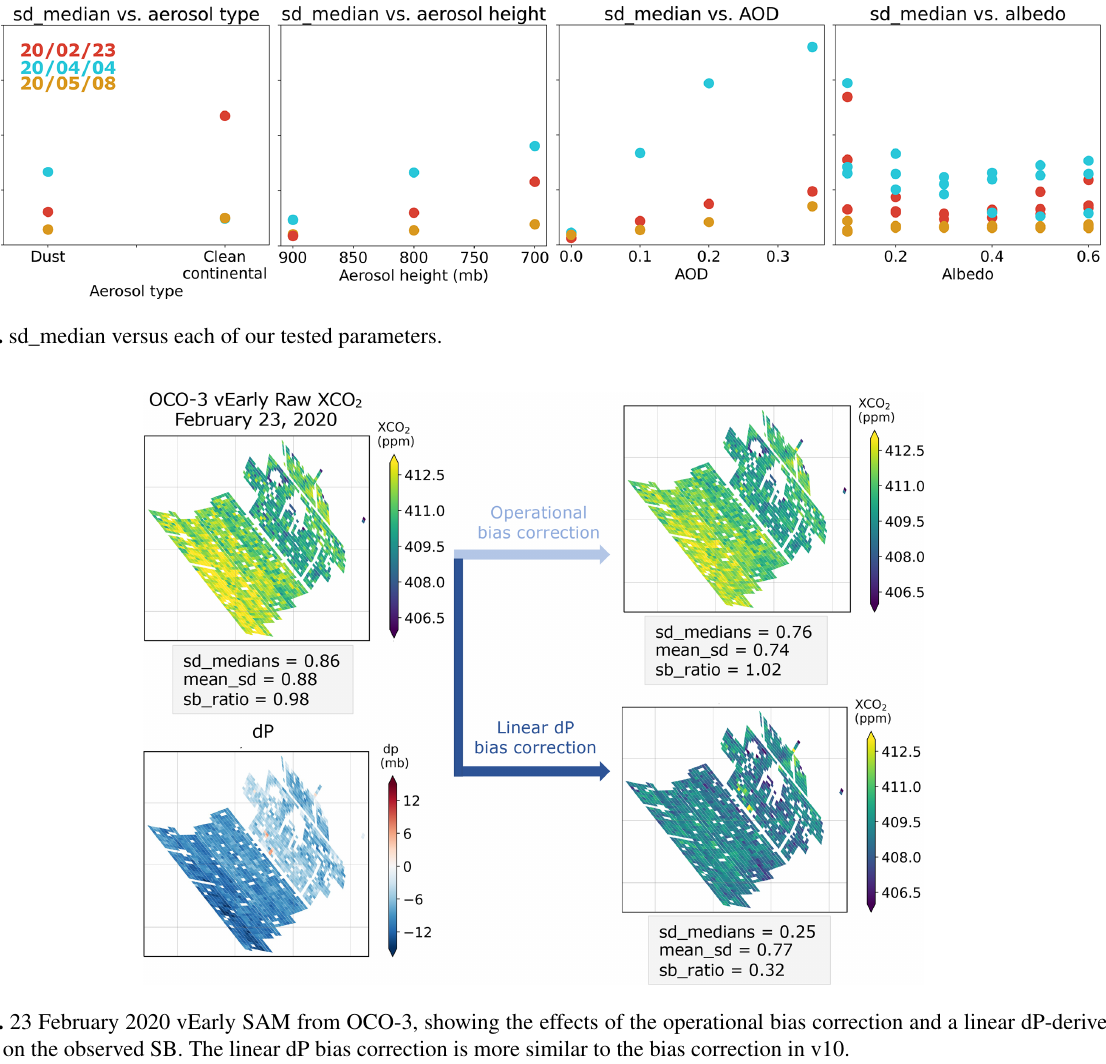
Figure 18. 23 February 2020 vEarly SAM from OCO-3, showing the effects of the operational bias correction and a linear dP-derived bias correction on the observed SB. The linear dP bias correction is more similar to the bias correction in